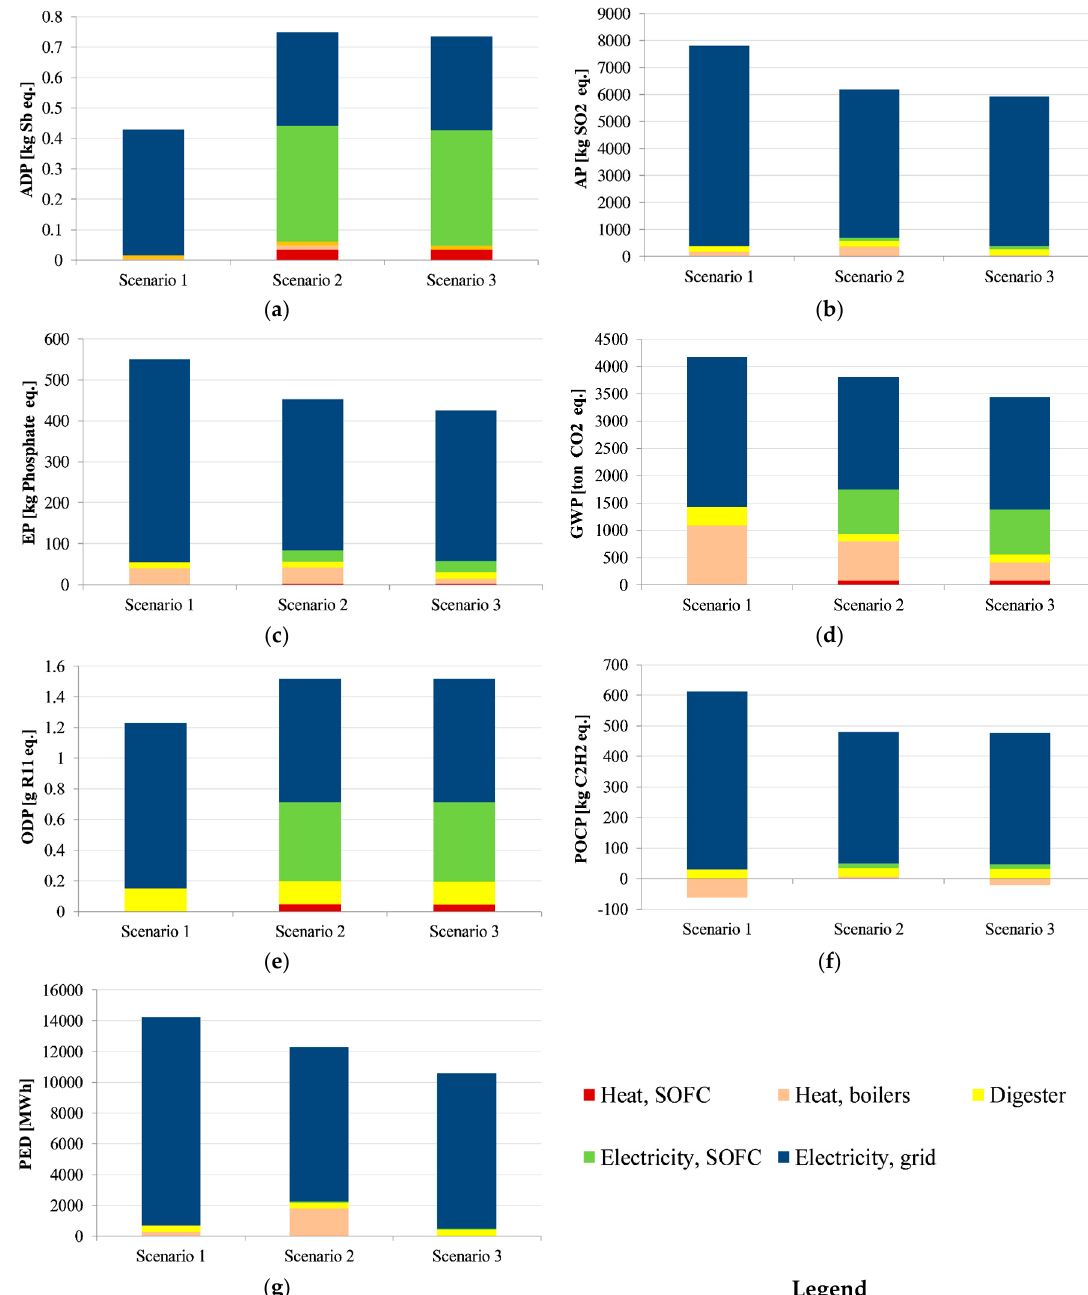
Figure 9. Impact categories result for the three analyzed scenarios. The following impact categories are shown: ( a ) ADP; ( b ) AP; ( c ) EP; ( d ) GWP; ( e ) ODP; ( f ) POCP and ( g ) PED.